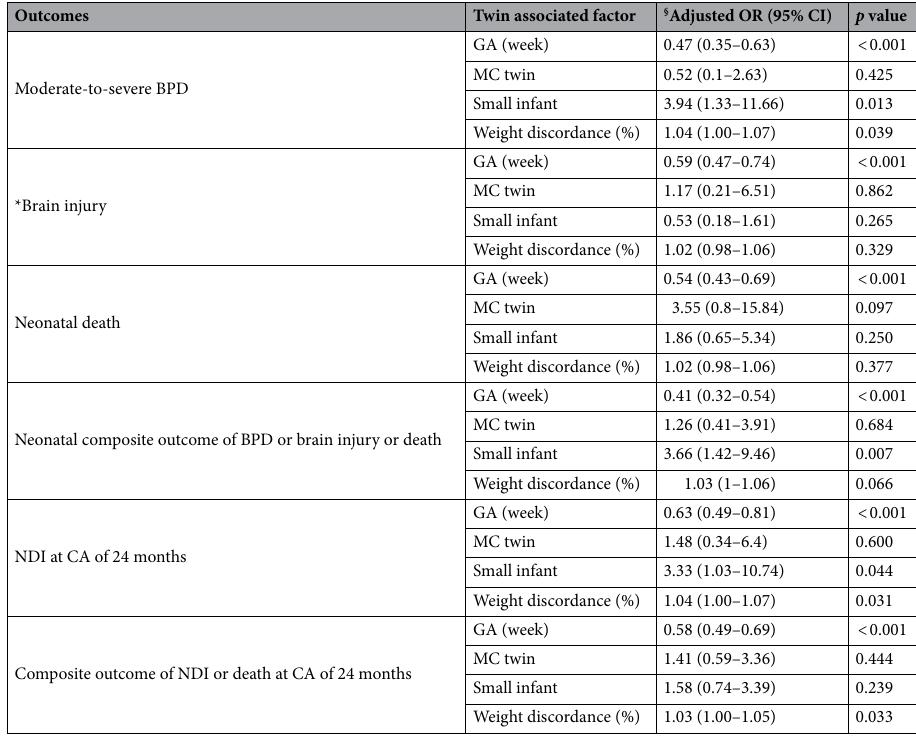
Table 3. Association of twin-related factors with neonatal and neurodevelopmental outcomes for the study population without TTTS. § Adjusted for gestational age, sex, MC twin, small infant, and weight discordance. Multiple logistic regression analysis was conducted among dichorionic and MC twins without twin-to-twin syndrome. OR Odds ratio, BPD Bronchopulmonary dysplasia, GA Gestational age, MC Monochorionic, NDI neurodevelopmental impairment, CA Corrected age. *Brain injury was defined as an intraventricular hemorrhage of grade ≥ 3 or periventricular